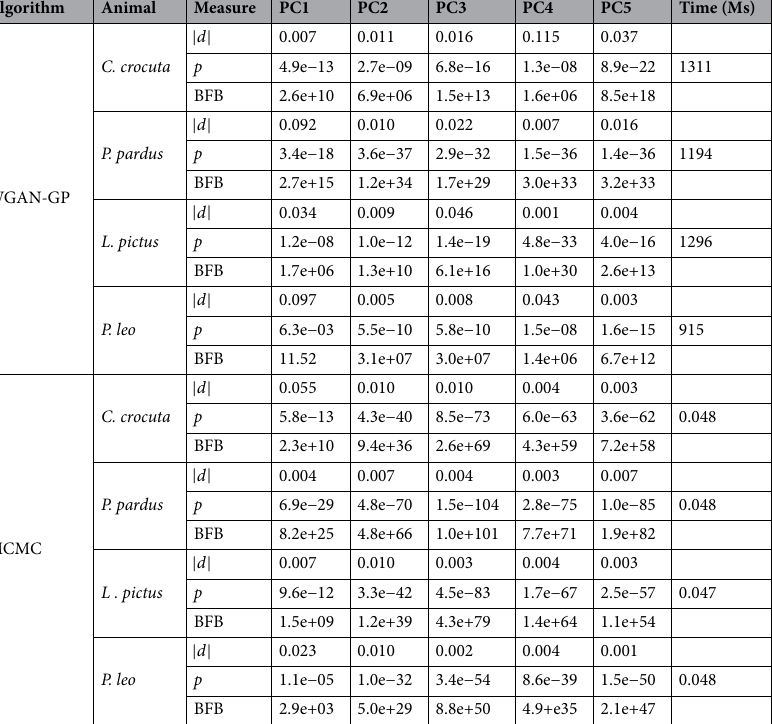
Table 1. Examples of absolute difference ( | d | ), p -Values and Bayes Factor Bounds (BFB) obtained when assessing the robust equivalency of synthetic data and real data using Gradient Penalty Wasserstein Loss Generative Adversarial Networks (WGAN-GP) and Markov Chain Monte Carlo (MCMC) Algorithms for data augmentation of the African Taxa dataset. Time values reported represent the number of miliseconds per epoch or iteration of the algorithm.